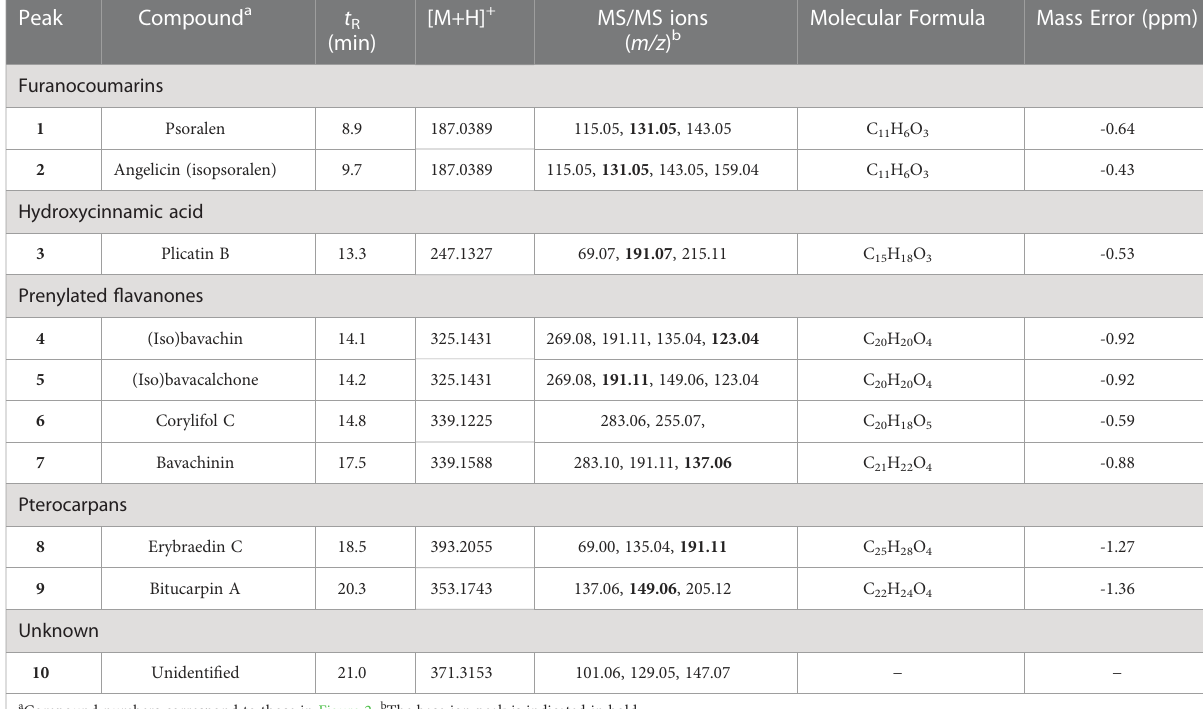
a Compound numbers correspond to those in Figure 2. b The base ion peak is indicated in